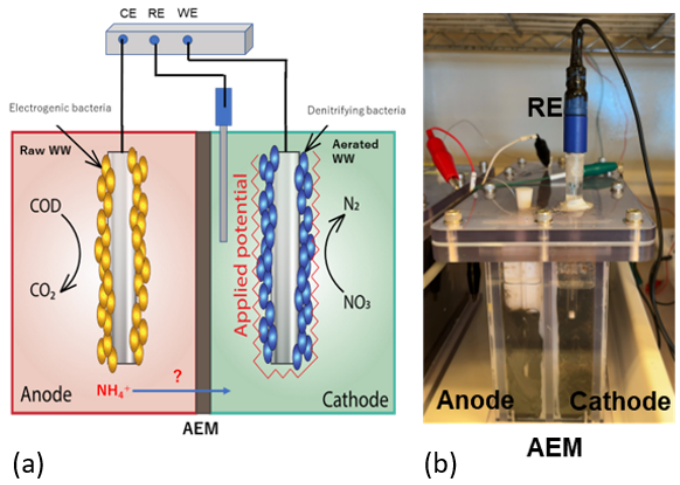
Figure 3. Two-chambered electrotrophic denitrification system. ( a ) Schematic diagram of the system. The anode chamber contains raw swine WW and the cathode chamber contains aerated WW. Two chambers are separated by AEM either produced in this study or commercial AMI-7001. ( b ) A photo of the reactor.